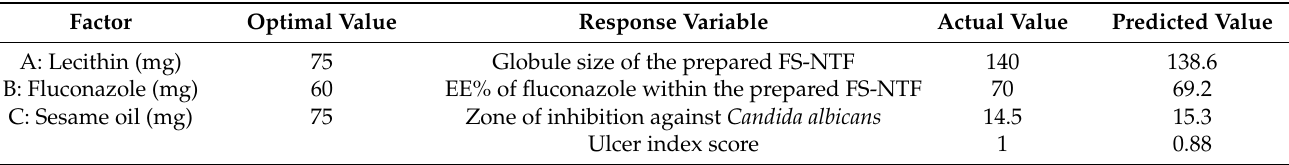
Table 7. Composition of the actual and predicted responses of the optimal FS-NTF formulation.